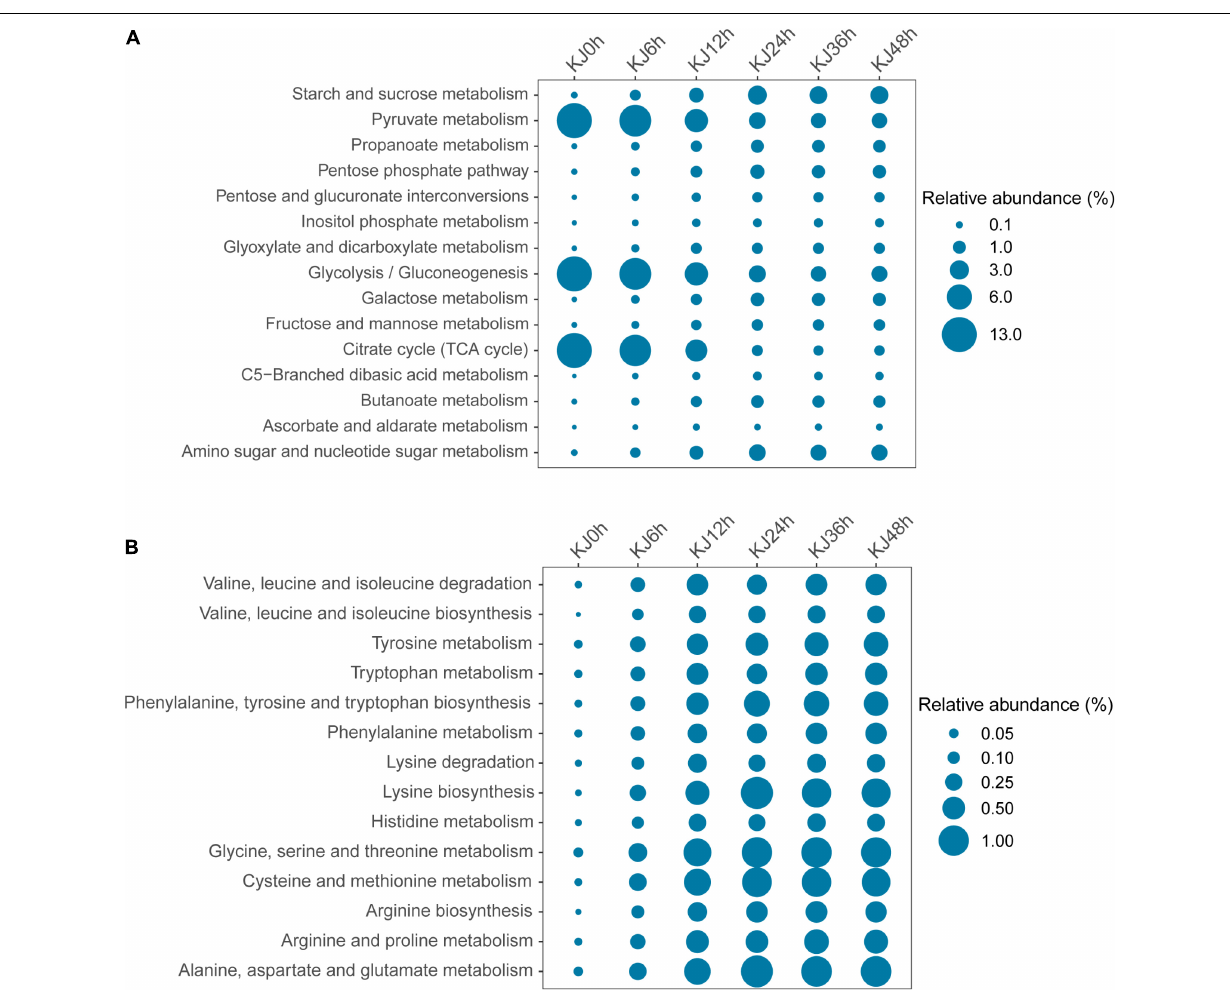
FIGURE 2 | Functional profiling of carbohydrate metabolism (A) and amino acid metabolism (B) genes from whole-shotgun metagenome data that were classified at level 3 of the Kyoto Encyclopedia of Genes and Genomes (KEGG) annotation